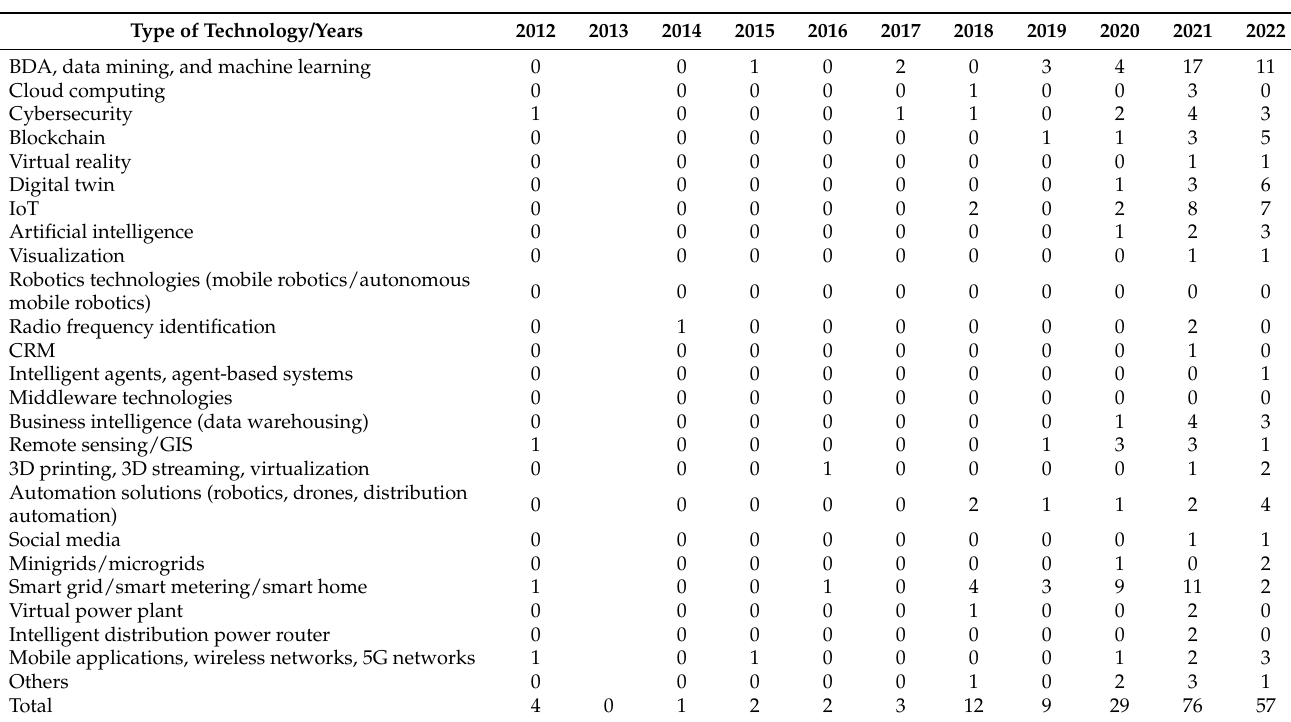
Table 4. The number of articles indexed annually in the Web of Science database during 2012–2020 focused on the technologies used for digitalization 1